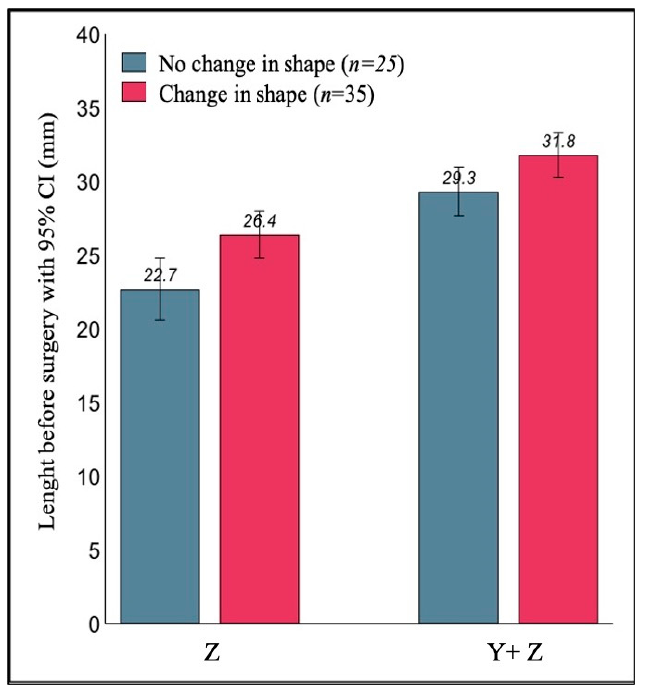
Figure 6. Mean Z and (Y + Z) values measured before surgery and their relationship with the change of the fundal uterine shape at three months after surgery.